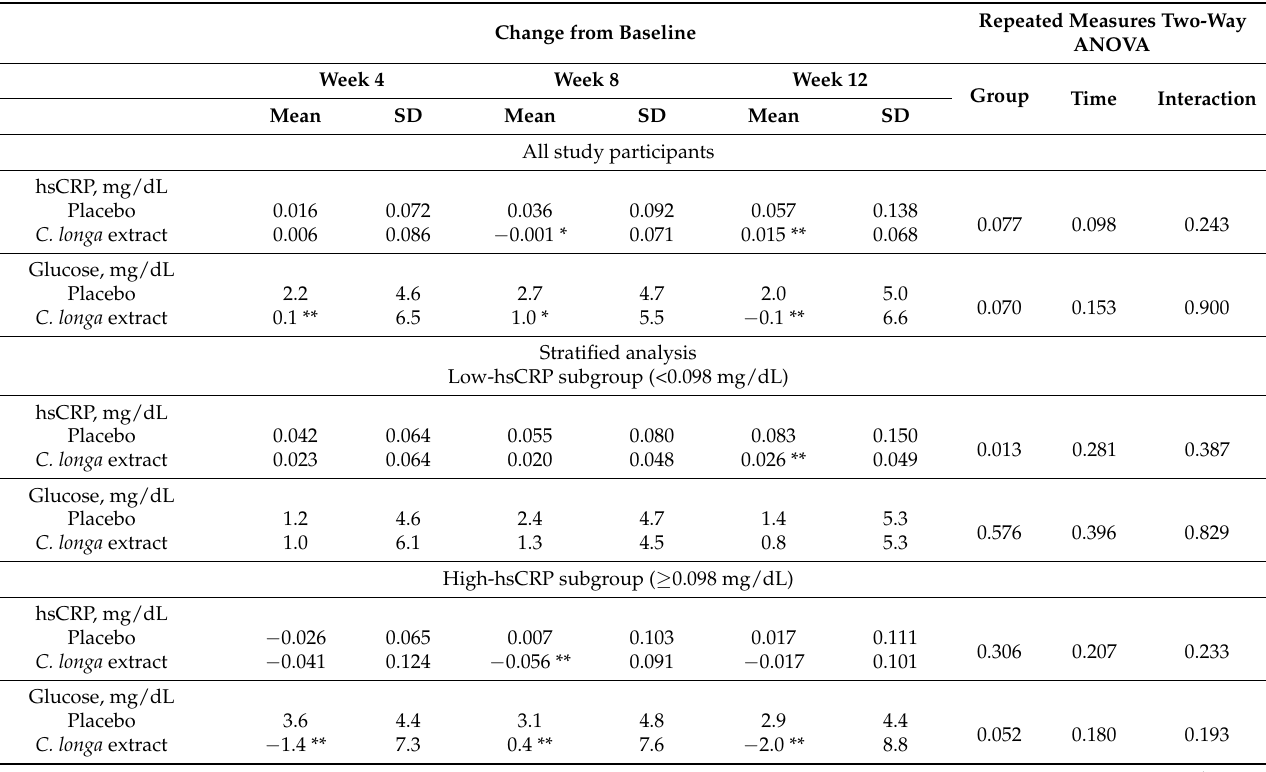
Repeated Measures Two-Way ANOVA Group Time Interaction